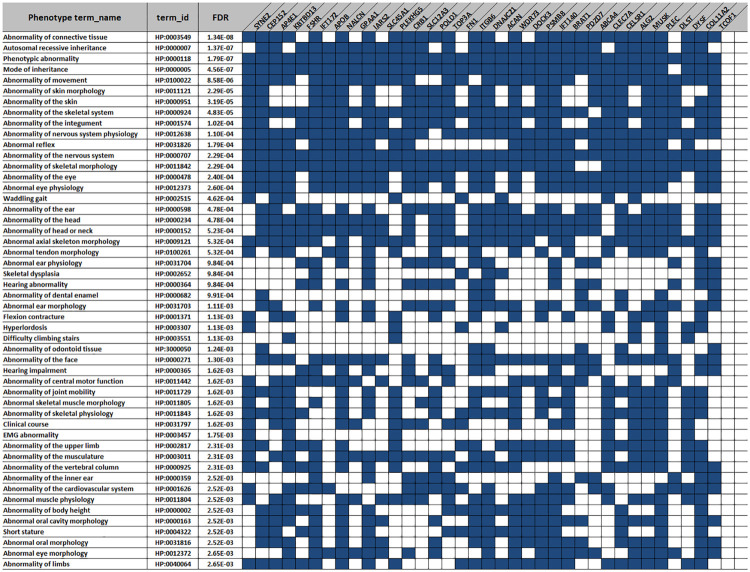
The top 50 phenotype terms for the 36 Chongming white goat (CM) breed-specific genes with the loss-of-function (LoF) variants. Blue squares indicate the genes (columns) involved in the specific phenotype terms (rows).